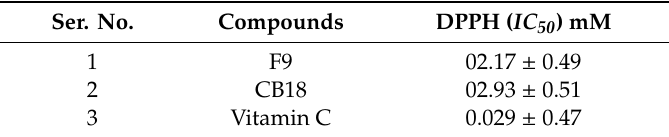
Table 3. Antioxidant activity of isolated compounds. Each value represents IC 50 of average of three repeated experiments ± standard error (S.E.). Ser. No.